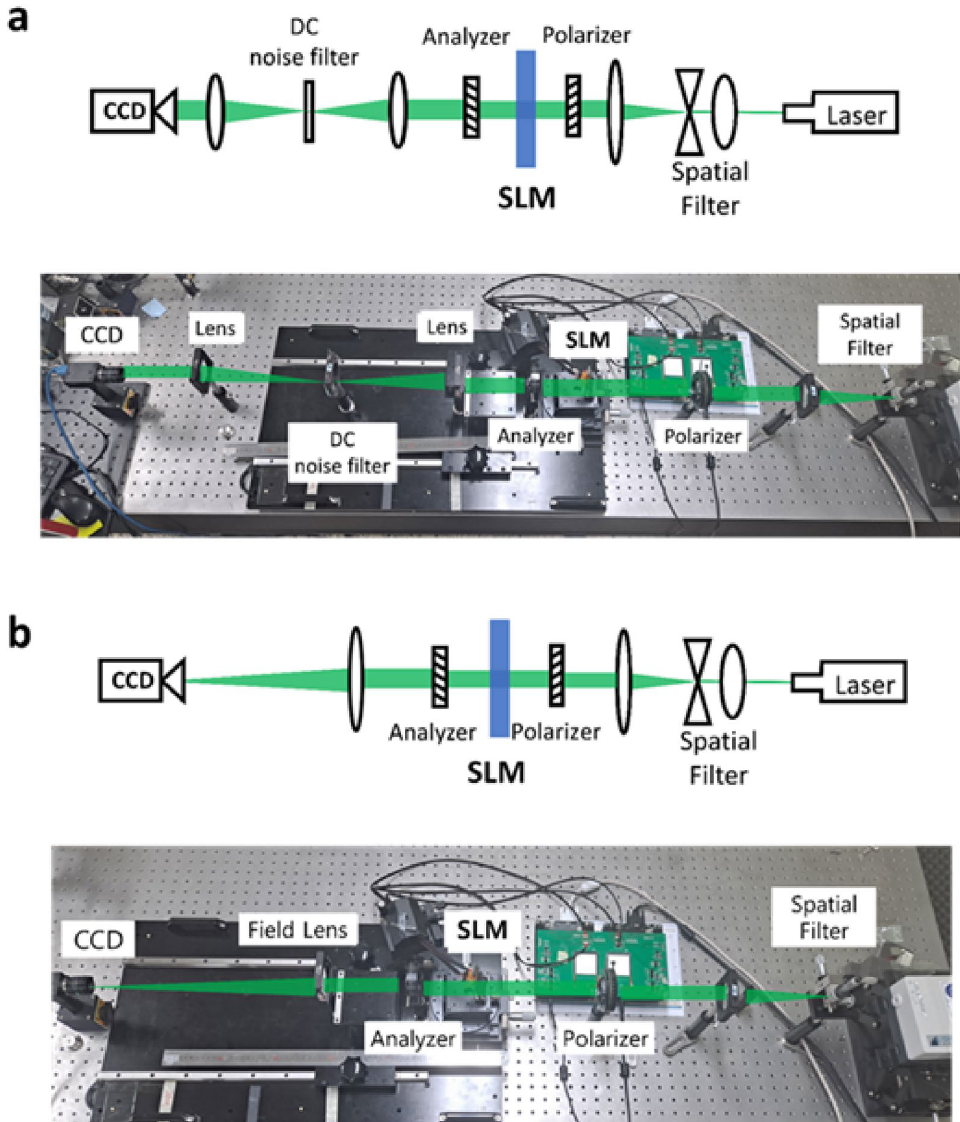
Figure 6. ( a ) Optical Fourier transform test setup and ( b ) 3D holographic image formation test setup. Schematics (upper panel) and implementation (lower panel) of the experimental systems are